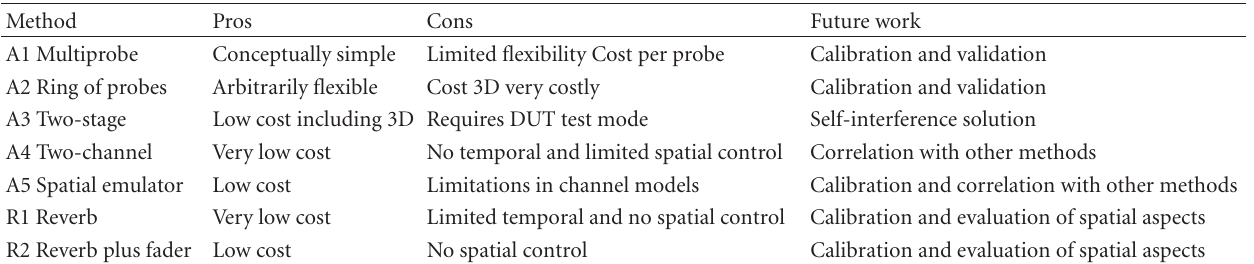
Table 1: Comparison of candidate